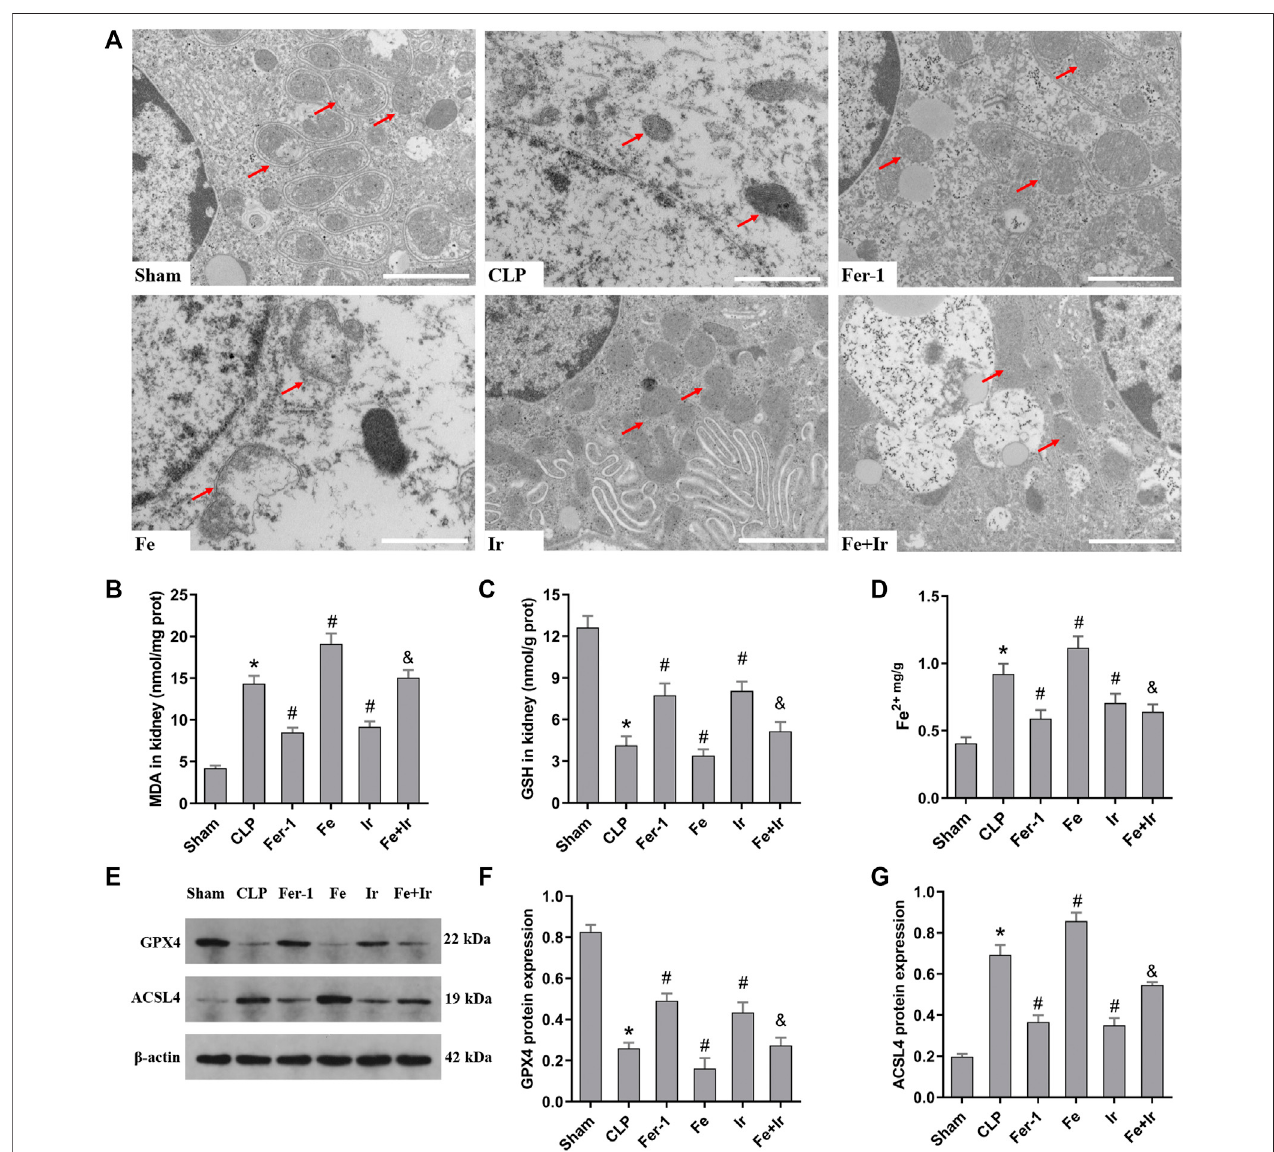
FIGURE 2 | Irisin alleviates the occurrence of ferroptosis in SA-AKI. (A) Representative TEM images (scale bar = 1 μ m, upper panels). The red arrow indicates representativemitochondriainmousekidney(n=3mice/group).ThelevelsofMDA (B) ,GSH (C) ,andFe2+ (D) inmousekidneyhomogenates.( n =10). (E) Westernblot analysisofGPX4andACSL4proteinsinthekidneytissue.( n =3). (F,G) Quantitationofresultsin (E) .* p < 0.05vs.Shamgroup, # p < 0.05vs.CLPgroup, & p < 0.05vs.Fe group. Data are presented as mean ± SD.